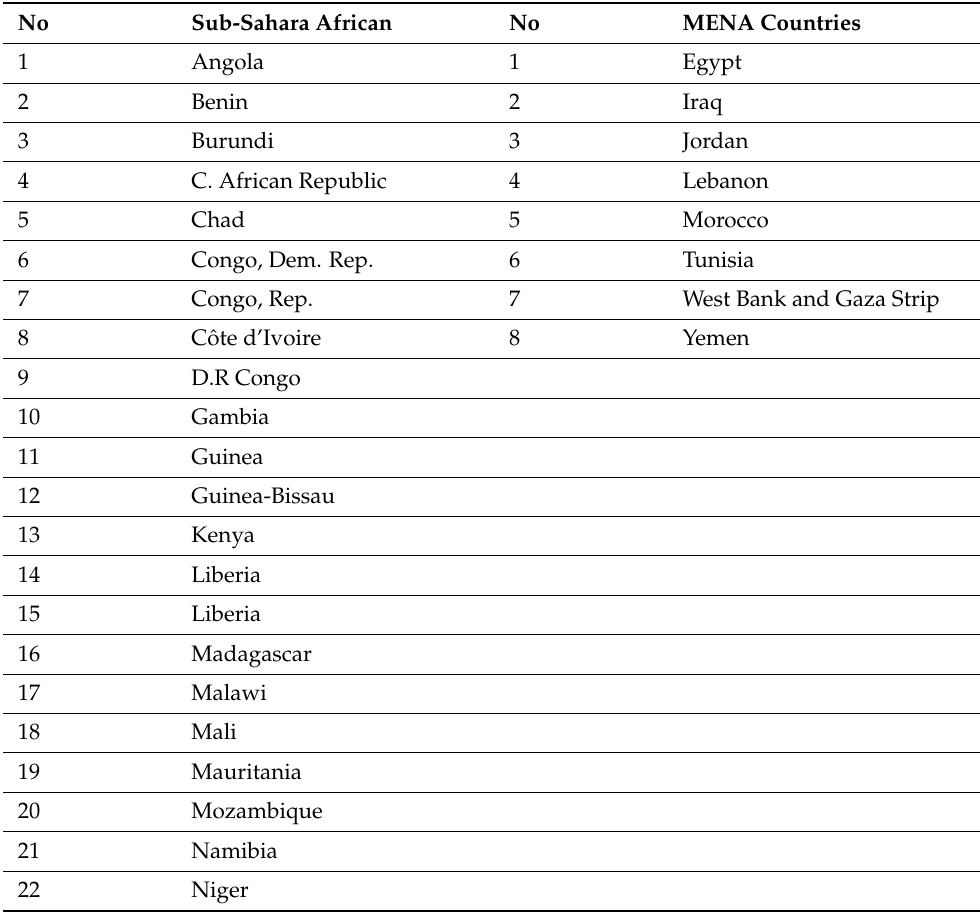
Table A12. 37 Selected Countries from SSA and MENA